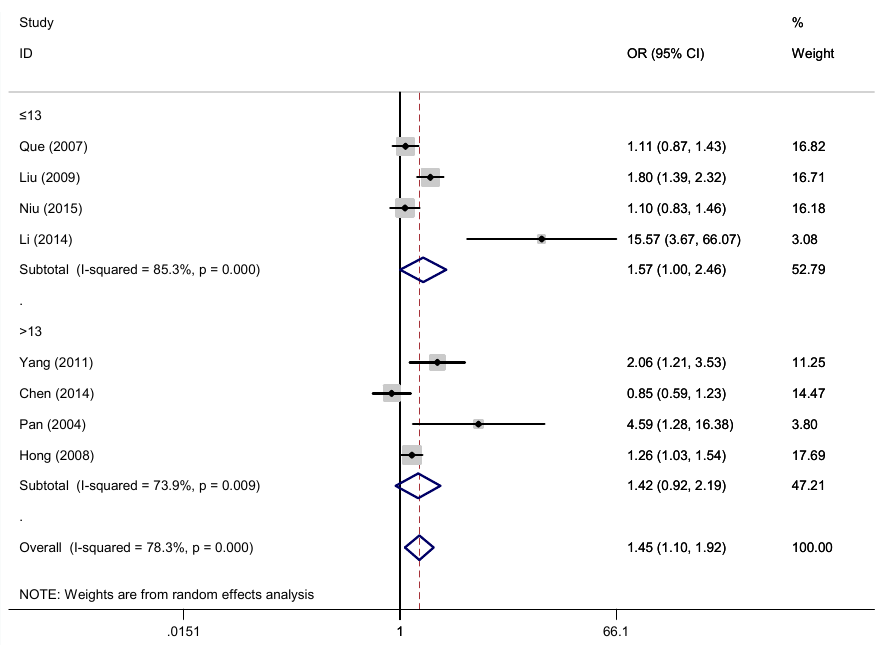
Figure 7. Subgroup analysis by regional distribution.